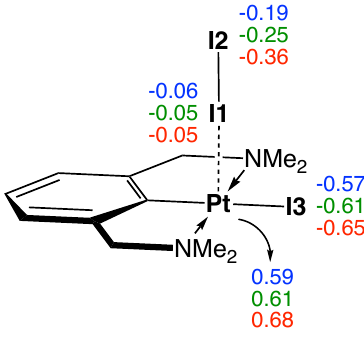
Figure 7. Atomic charges of Pt and I atoms of 1 in the gas phase (blue), in benzene (green) and in acetone (red). PBE0–D3(BJ)/aug–cc–pVTZ/PP(M,I)/SMD level of theory. Table 2. Bond length and local mode force constant of selected atoms of the molecular system 1 in the gas phase and in solution a . Gas Phase Benzene Acetone Atoms